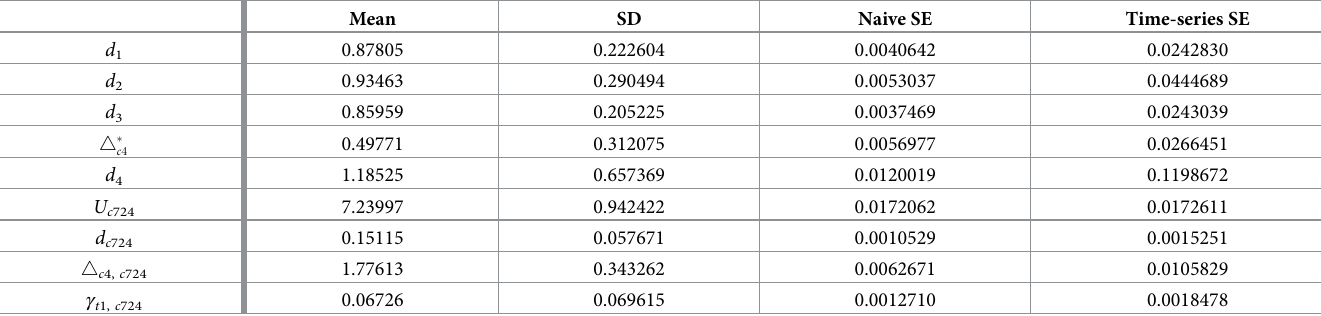
Table 1. Empirical mean and standard deviation for each variable, plus standard error of the mean.